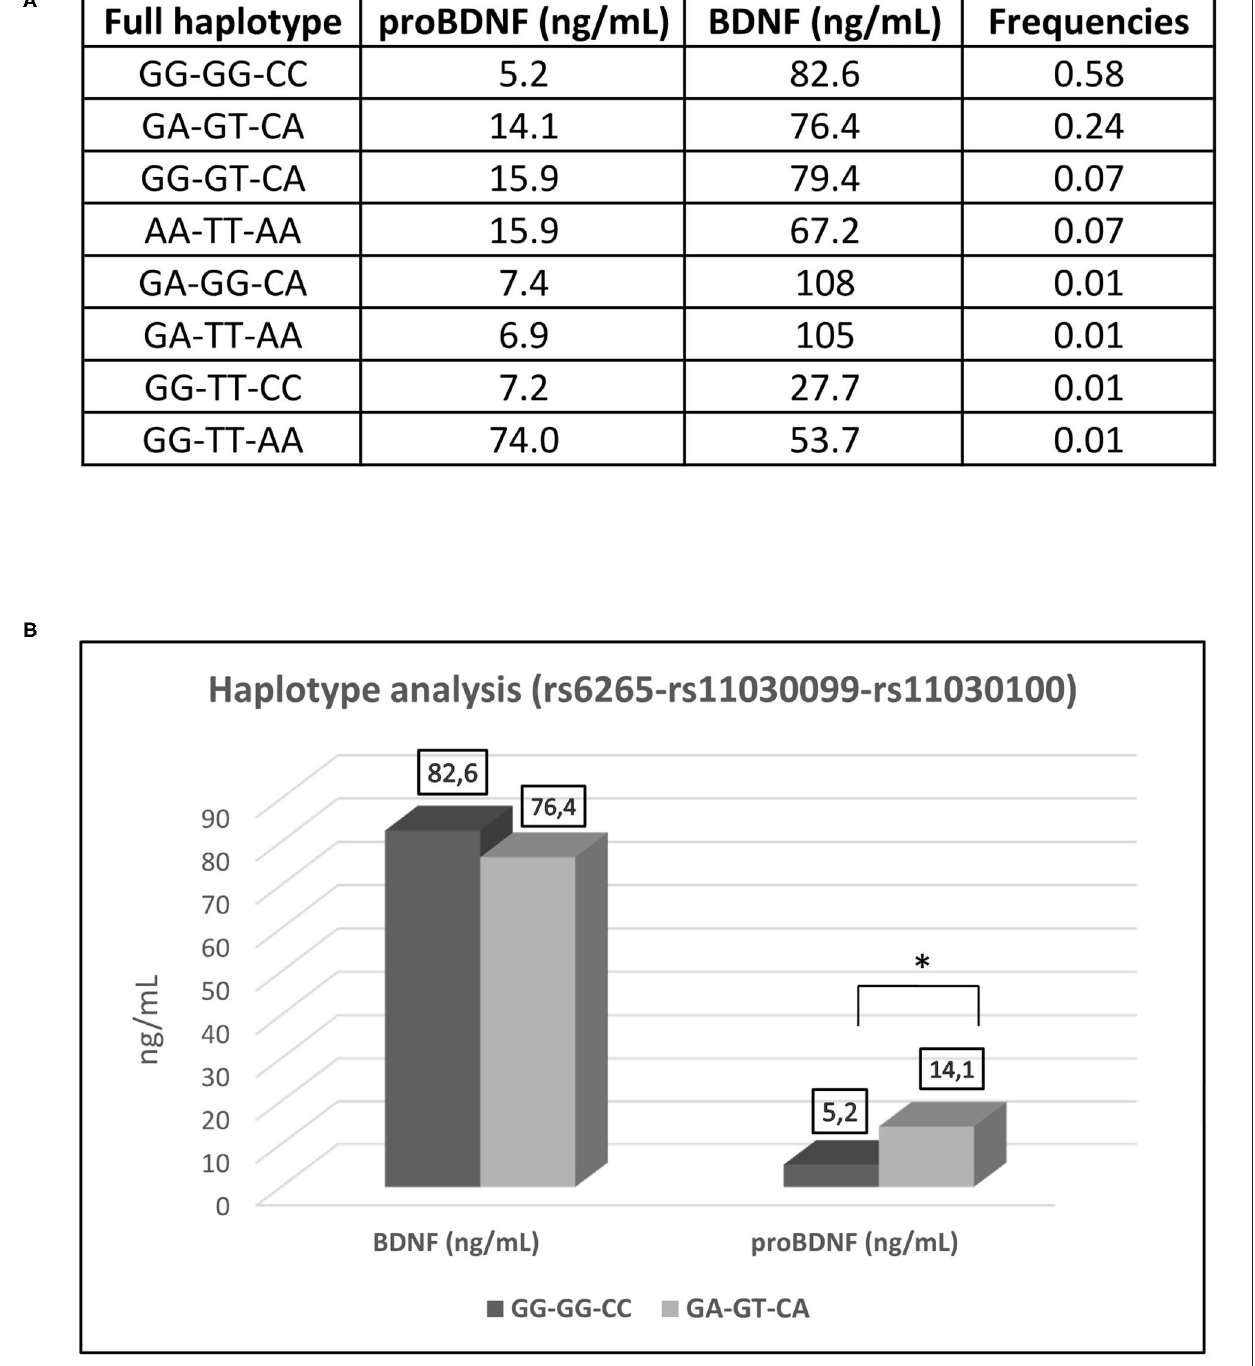
negative correlation found with proBDNF and BDNF, other statistically significant correlations have been found only between BDNF vs. IL-33, PDGF-AA, and TGF alfa ( r = 0.33,